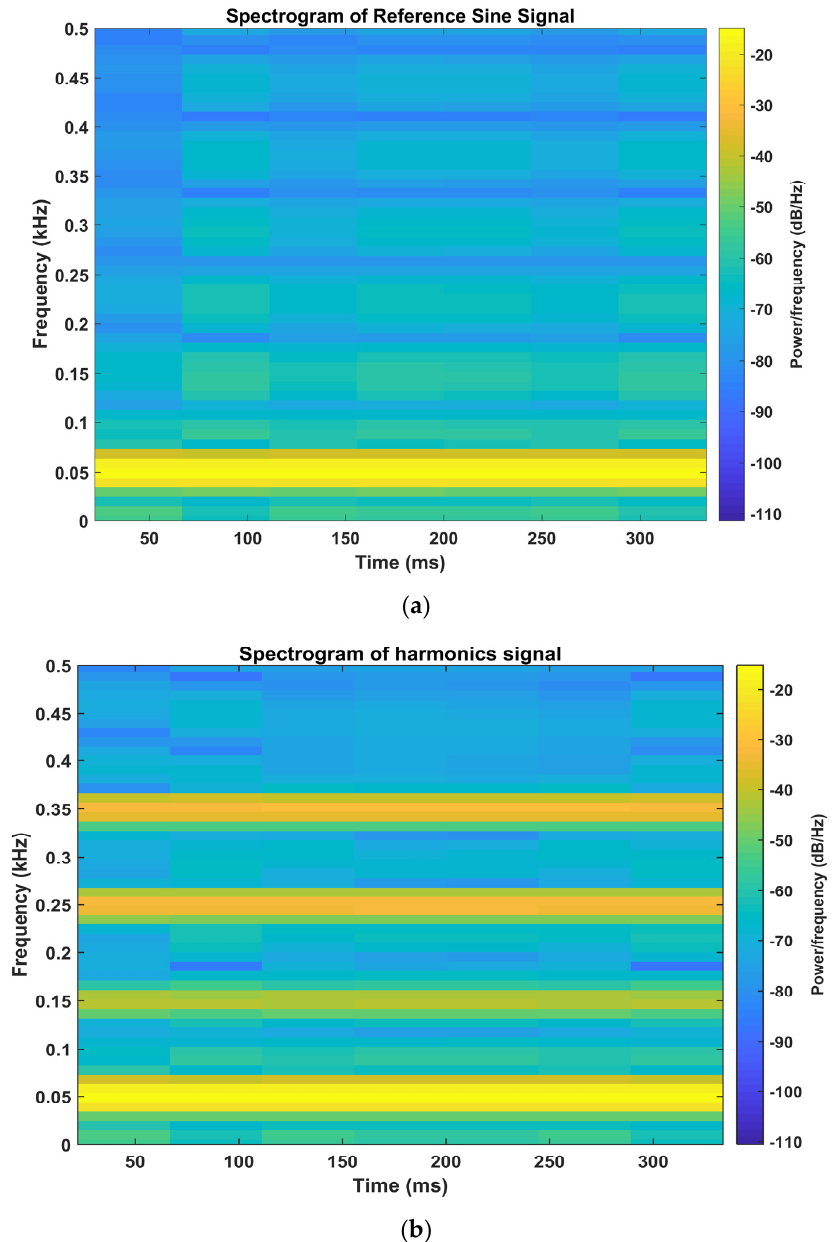
Figure 5. ( a ) Spectrogram of the reference sine signal with the color map. ( b ) Spectrogram of harmonics signal with time on the abscissa and the frequency on the ordinate.